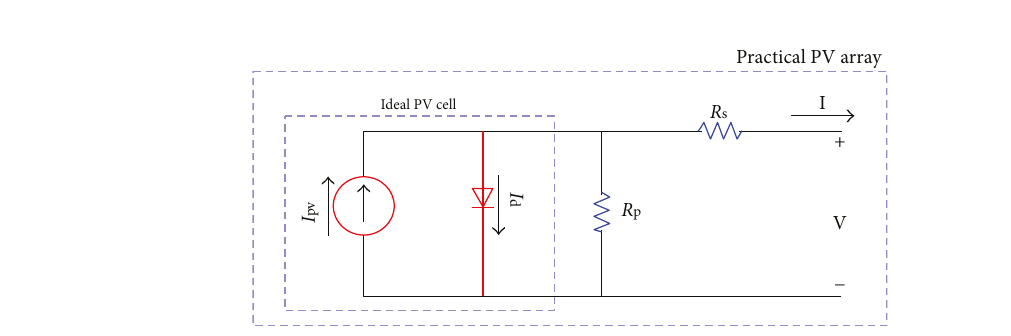
Figure 4: Equivalent model of a PV